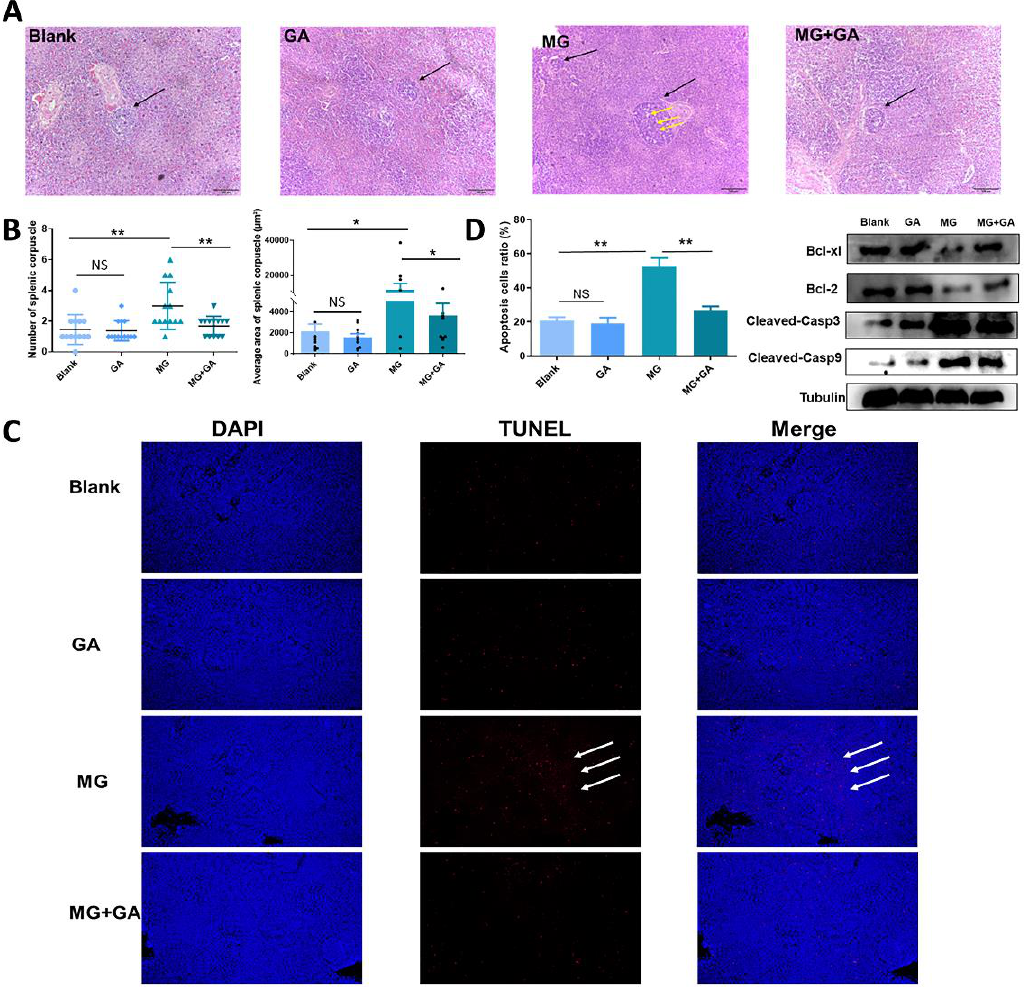
Figure 6. Neutralization of HMGB1 alleviates MG-induced splenic damage. ( A ) Spleen tissue sec-tion (H & E staining). Orange arrows shows lymphocytes shedding and splenic lymph nodes were significantly enlarged. Splenic corpuscle (black arrows). ( B ) The number of splenic corpuscles and the mean area of splenic corpuscle. ( C ) TUNEL assay kit was used to detect the extent of apoptosis in the spleen tissue. White spots (scale = 50 µm) indicate positive TUNEL staining (apoptotic cells). Bar graph shows mean results ± SD (n = 3). ( D ) Left: Quantification of the degree of spleen tissue apoptosis by fluorescence intensity. Right: The proteins of apoptosis genes were detected by Western blotting. Tubulin was used for normalization. NS p > 0.05. * p < 0.05, and ** p < 0.01 show statistically significant difference compared to the MG group. Black dots in bar graph represent datasets from independent experiments.